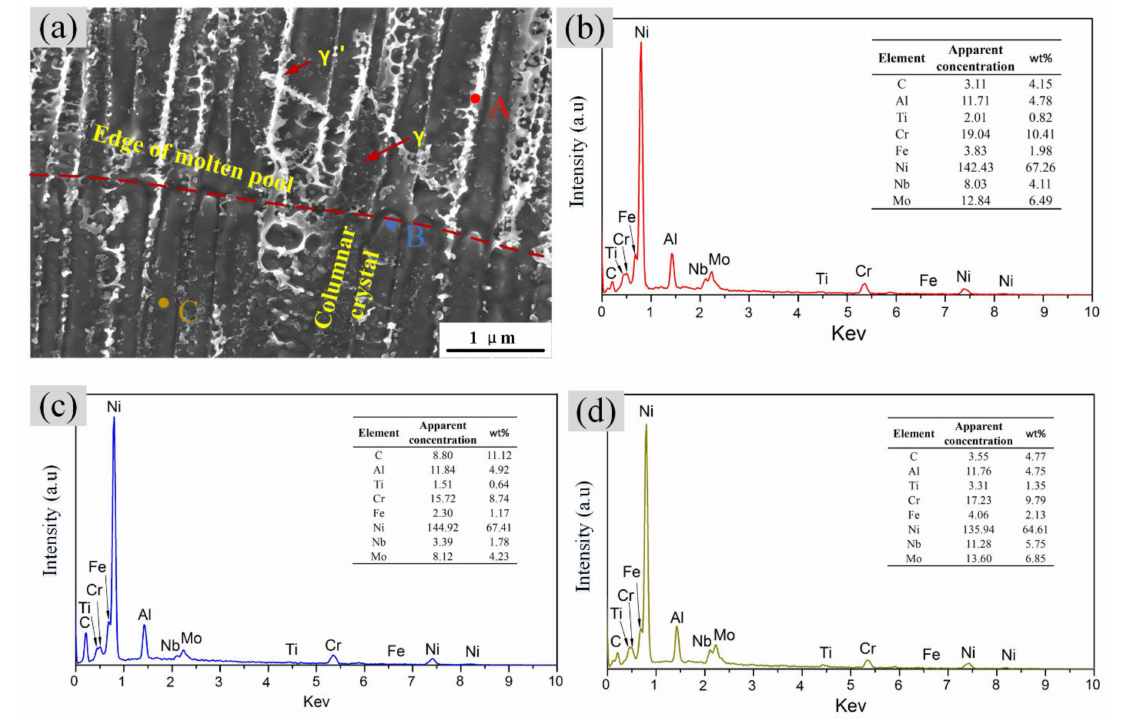
Figure 6. SEM and EDS scanning element distribution of the LPBF-manufactured K418 sample. ( a ) Columnar crystal morphology ( b ) Element composition of point A ( c ) Element distribution of point A ( d ) Element distribution of point